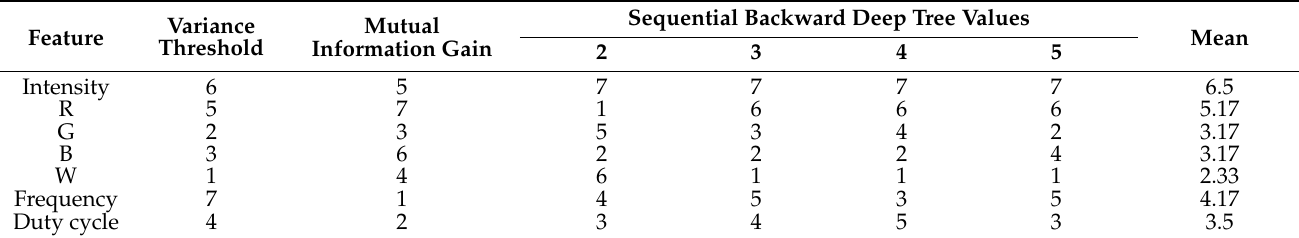
Table 13. Elimination order for the nonlinear model group.